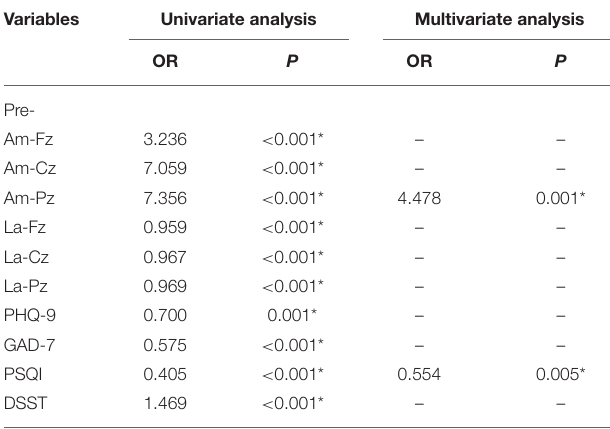
TABLE 8 | Factors associated with better therapeutic effect on alcohol dependence by binary logistic regression analysis ( n =